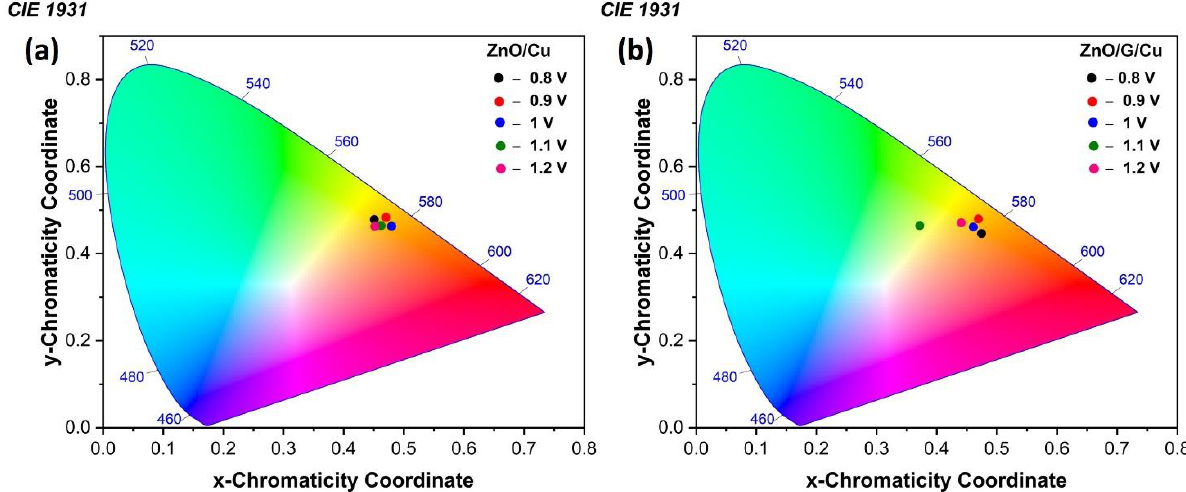
Figure 14. The CIE chromaticity diagram for ( a ) ZnO/Cu, ( b ) ZnO/G/Cu films.